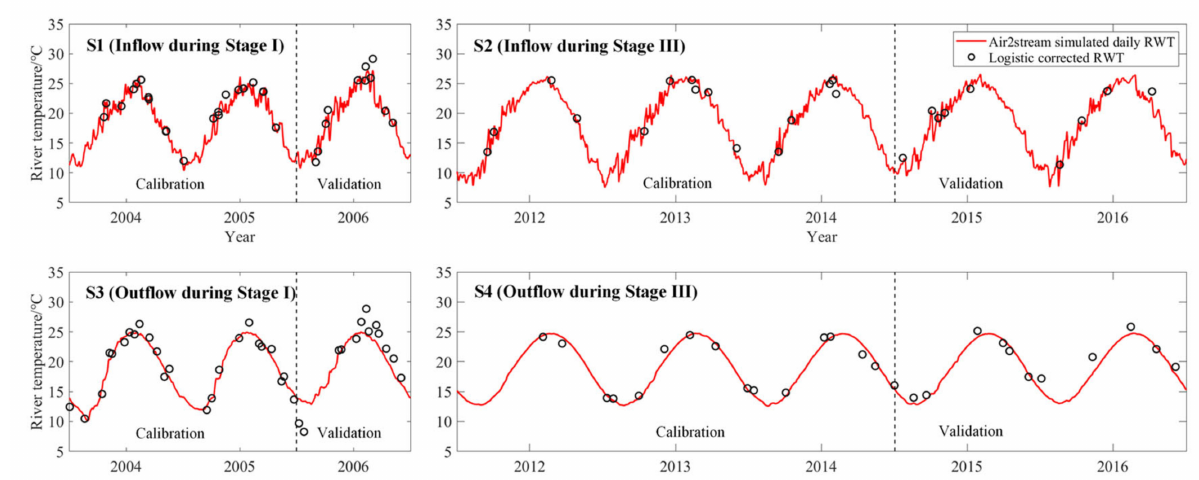
Figure 6. Relationship between logistic-corrected RWT and air2stream estimated daily RWT in different conditions. The RMSE of the estimated daily RWT under each situation are presented in Table 2.